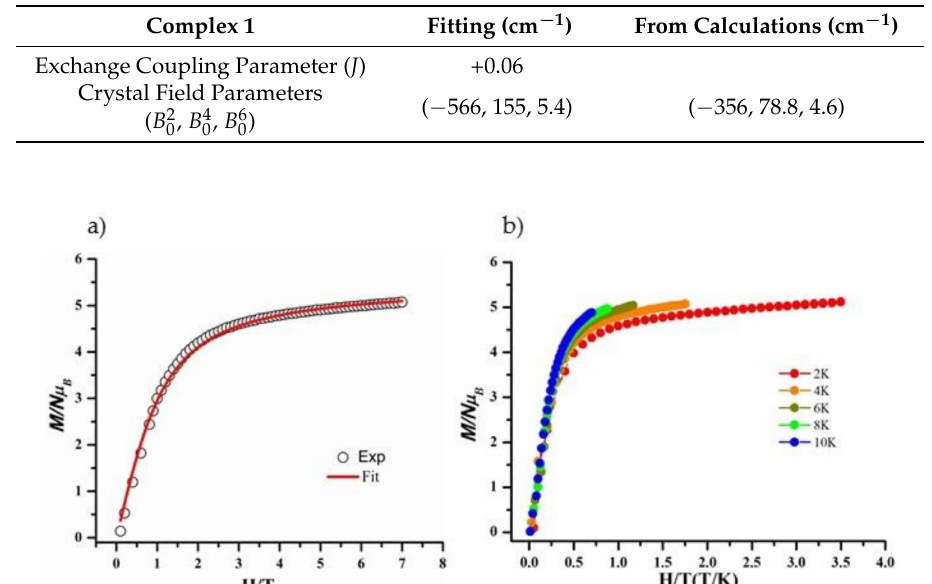
Figure 4. ( a ) DC magnetization as a function of the applied field, M(H), at 4 K and, ( b ) reduced magnetization plot in the field range of 0–7 T and temperature range of 2–10 K for complex 1